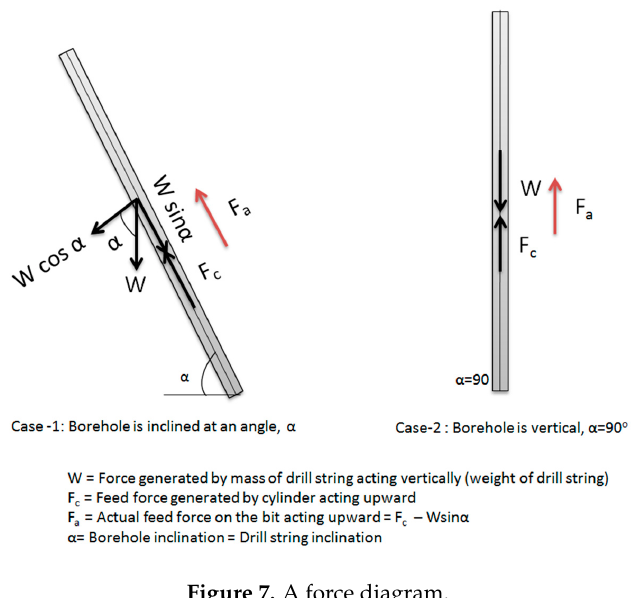
Figure 7. A force diagram.